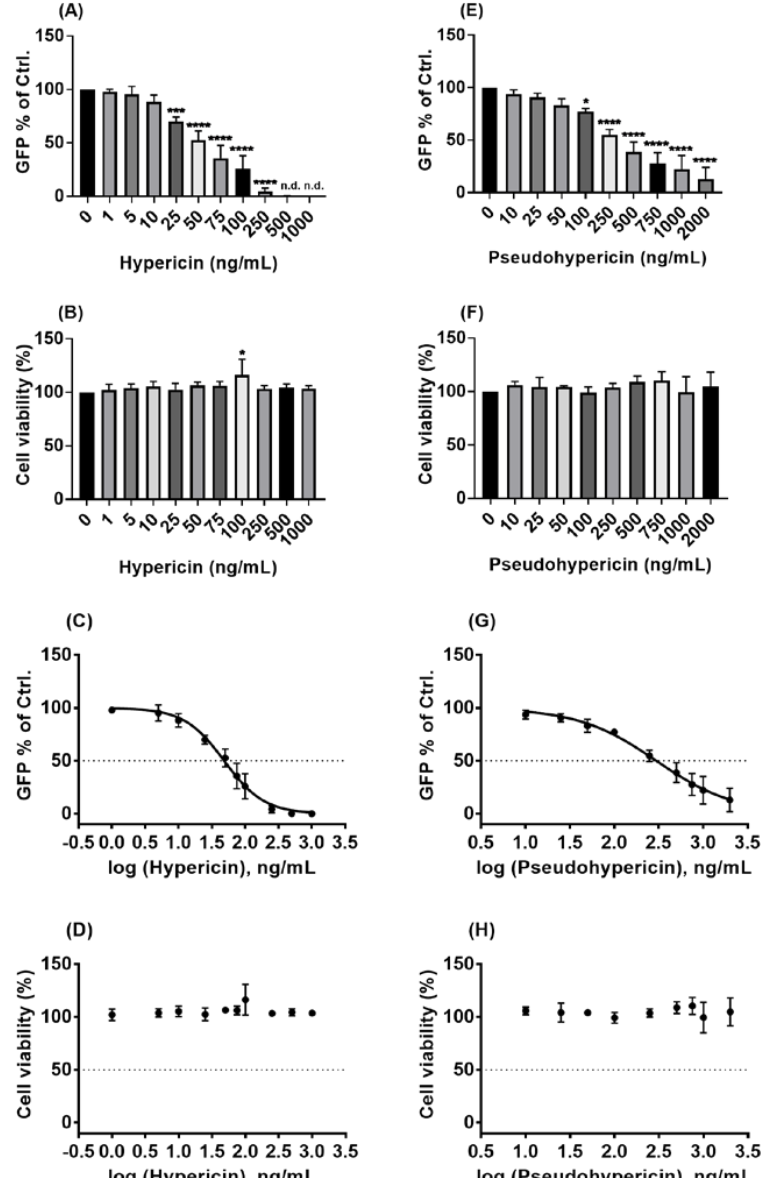
Figure 3. Hypericin and pseudohypericin showed a strong antiviral activity against the pseudo- typed VSV virus. ( A , C , E , G ) Vero cells were seeded overnight, and the next day, prior to infection (MOI = 0.01), both cells and the VSV pseudo-typed virus were incubated with the indicated sub- stances or solvent control (DMSO) for 1 h, at 37 °C and room temperature, respectively. After the pre-incubation, cells were infected for 1h and finally washed and incubated without further treat- ments. ( A , E ) GFP-positive cells as % of solvent control are shown (mean and s.d.), and one-way ANOVA with Dunnett’s multiple comparisons was done by comparing each value with the control. ( B , D , F , H ) Vero cells were seeded overnight, and the next day, incubation with the indicated substances or solvent control (DMSO) was initiated. After the 24 h incubation, MTT assay-based cytotoxicity was measured. ( B , F ) Cell viability as % of solvent control is shown (mean and s.d.), and one-way ANOVA with Dunnett’s multiple comparisons was done by comparing each value with the solvent control. ( C , G ) Dose–response curve of the normalized GFP-positive cell values as % of solvent control is depicted (mean and s.d.). ( D , H ) Dose–response curve of the normalized cytotoxicity values as % of solvent control is depicted (mean and s.d.). n.d means non-detected, * for p ≤ 0.05, *** for p ≤ 0.001, and **** for p ≤ 0.0001.